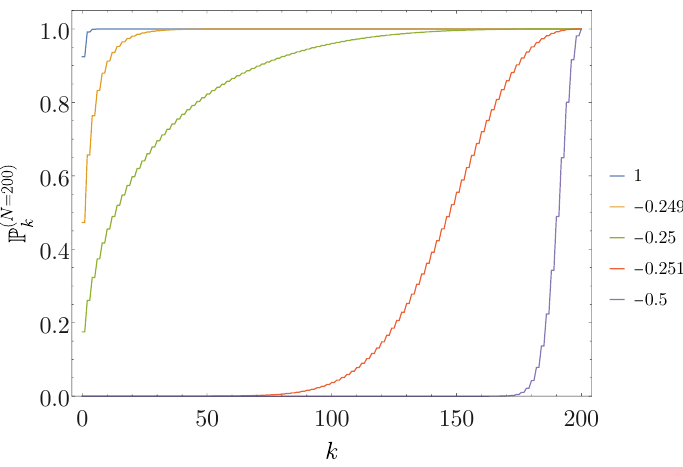
to find the truncation ground state | Ω i in the first k Fock space states, Figure 43. Probability P ( N ) k working at cutoff N = 200 . For g = 1 the ground state has almost no overlap with high-energy states. As g & g , the overlap with states close to the cutoff grows dramatically, and for values of ? g below g ? , the ground state is very UV-sensitive.